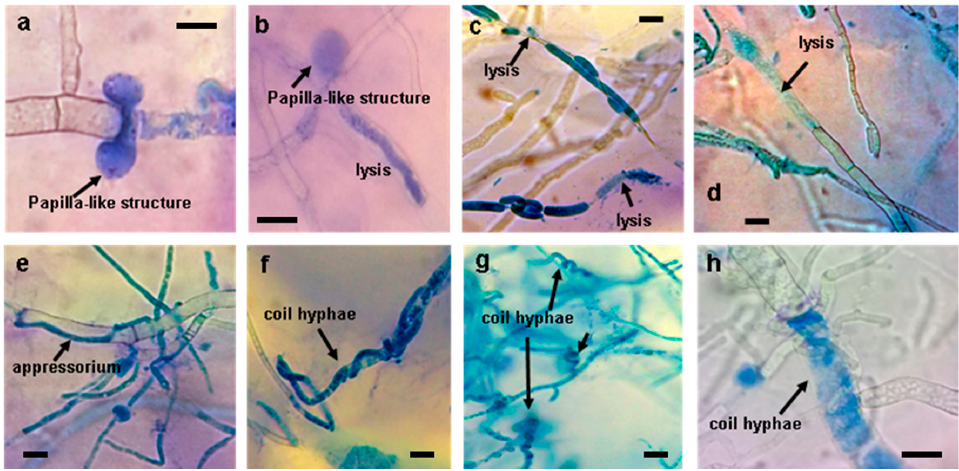
Figure 4. Interaction of Trichoderma spp. with pathogenic species in dual plate confrontation. Table 4. Radial growth (in mm) of pathogens (mean value ± SD of three replicates) inoculated in a potato dextrose agar (PDA) medium containing 0.5, 1, and 2% extract of metabolites filtered from liquid cultures of Epicoccum purpurascens at 5, 10, and 15 dpi.